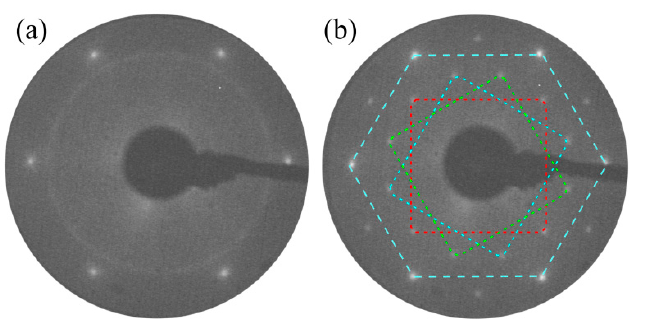
Figure 15. Low ‐ energy electron diffraction (LEED) patterns (55 eV) for Mn ‐ film ‐ covered GaN(0001) after annealing at ( a ) 500 and ( b ) 800 °C. The three domains of the square structure of the MnGa alloy and the (1 × 1) hexagonal structure of the GaN(0001) substrate are marked. Data previously published in [23] .